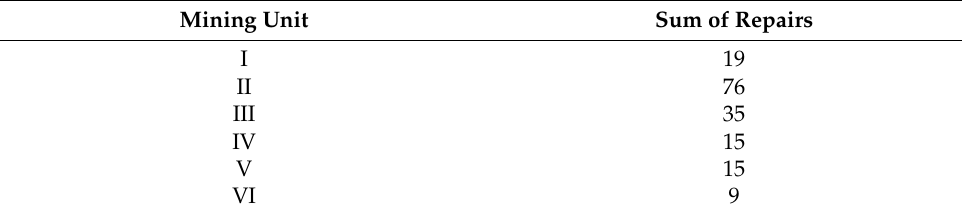
Table 2. Sum of A, B, and C elements repair in I–VI mining